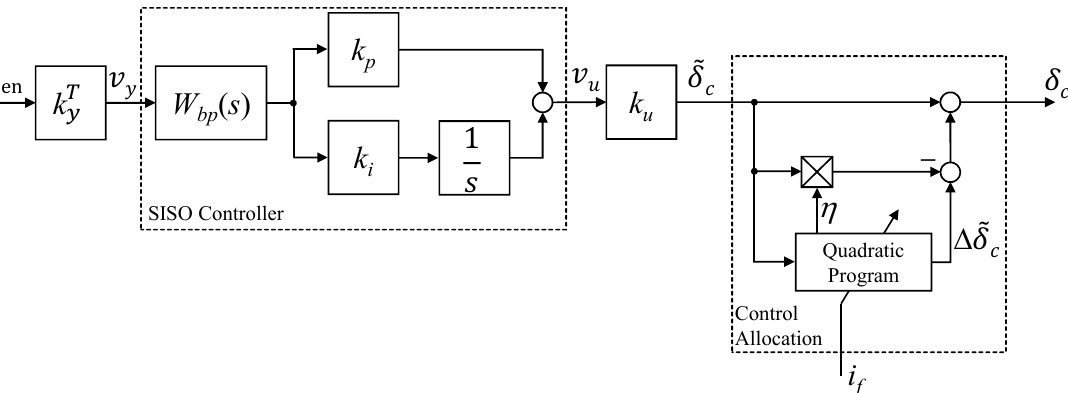
Figure 8. Single-input and single-output (SISO) controller illustration with blending vectors k y and k u and control